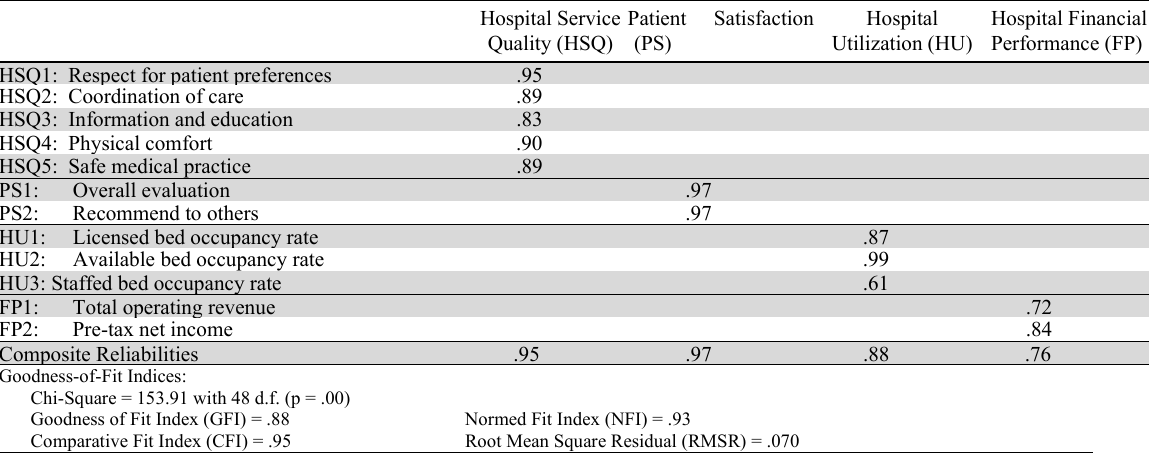
Confirmatory Factor Analysis